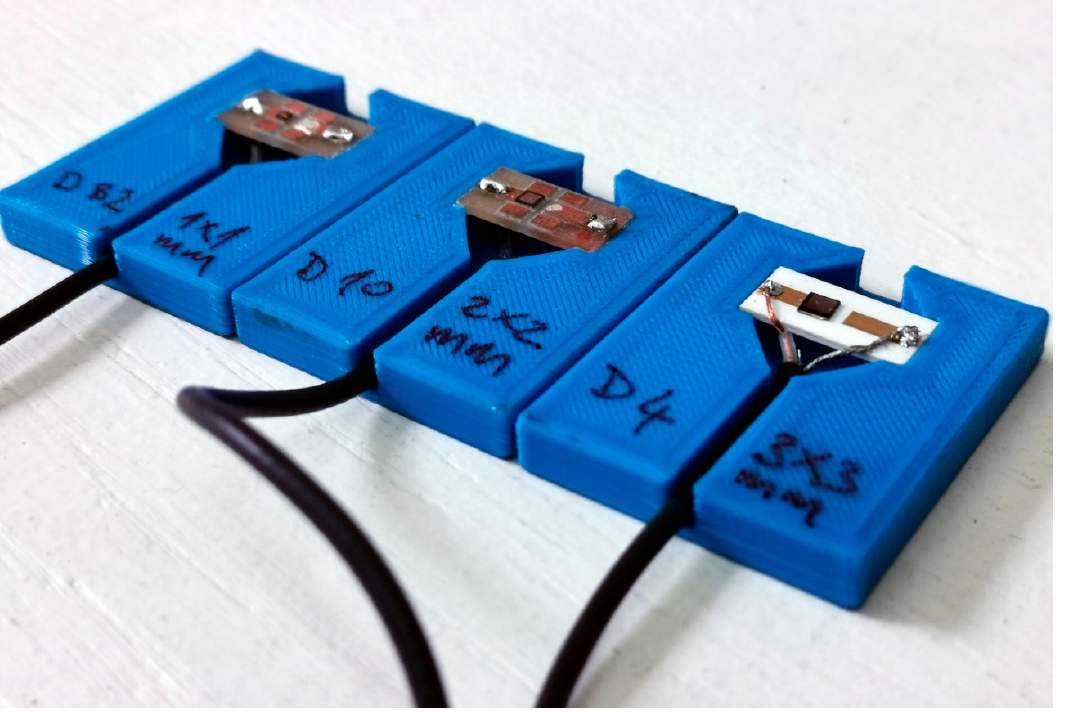
Figure 2. Three SBDs with different active volume were mounted into plastic enclosures.